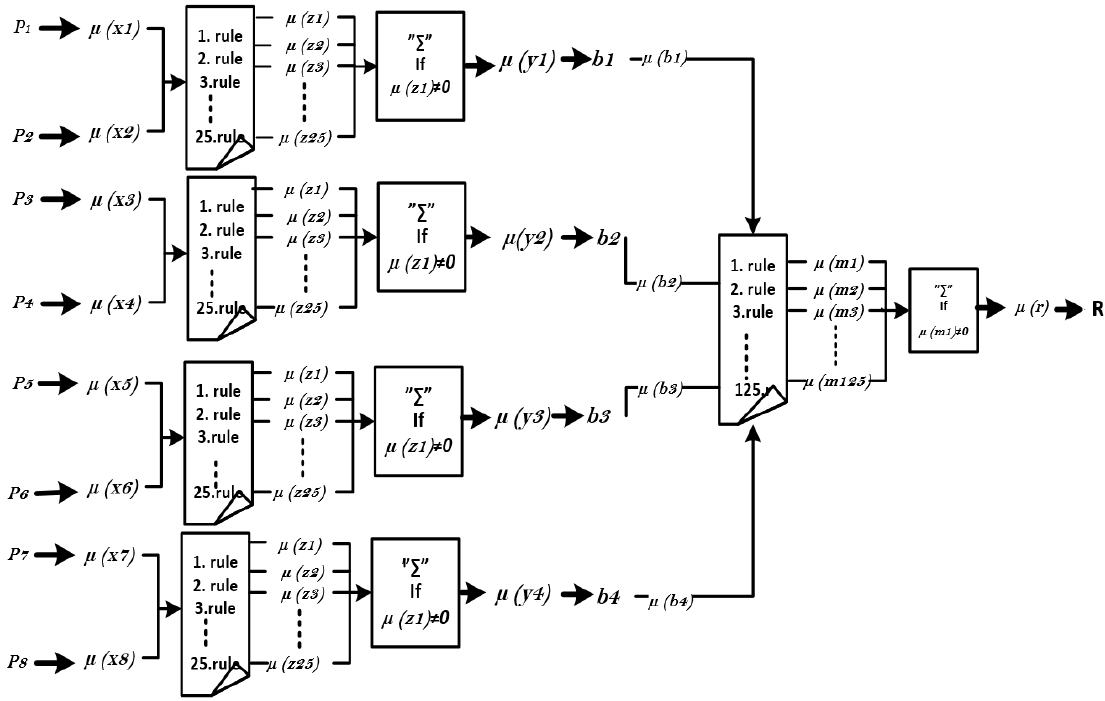
Figure 5. Proposed model fuzzy inference system.